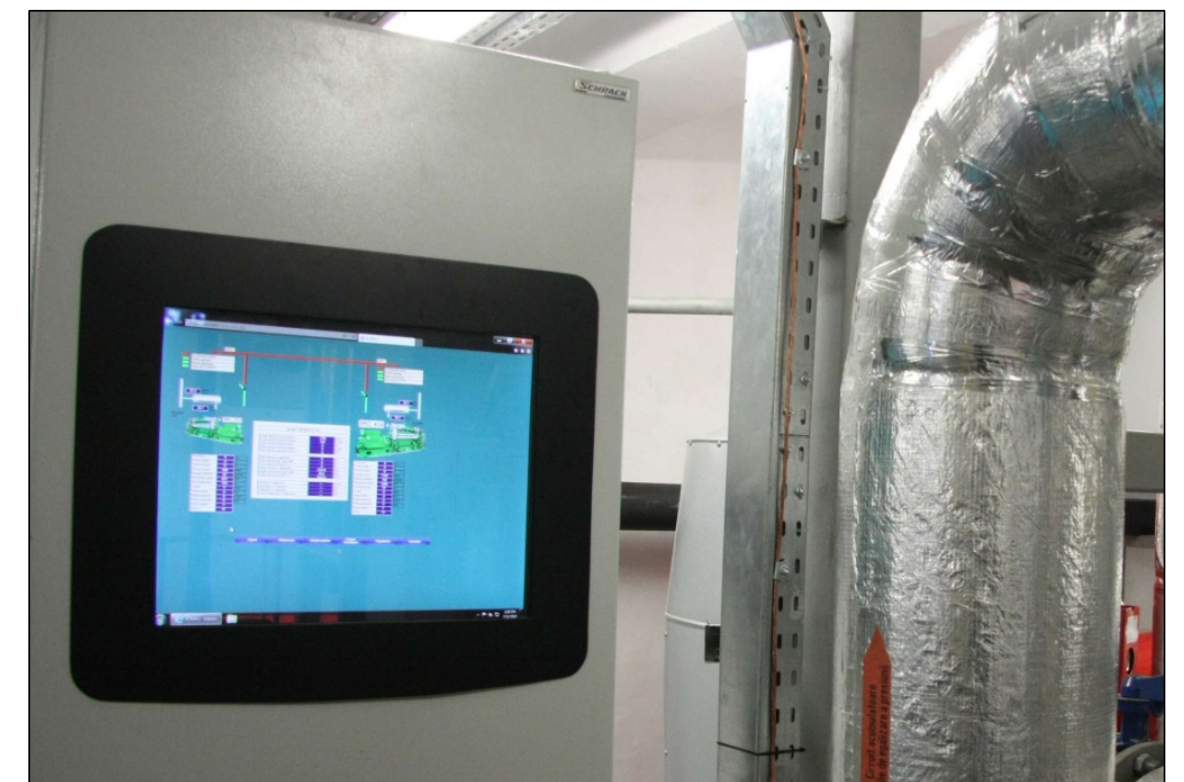
Figure 8. The PLC that controls and monitors the cogeneration plant.